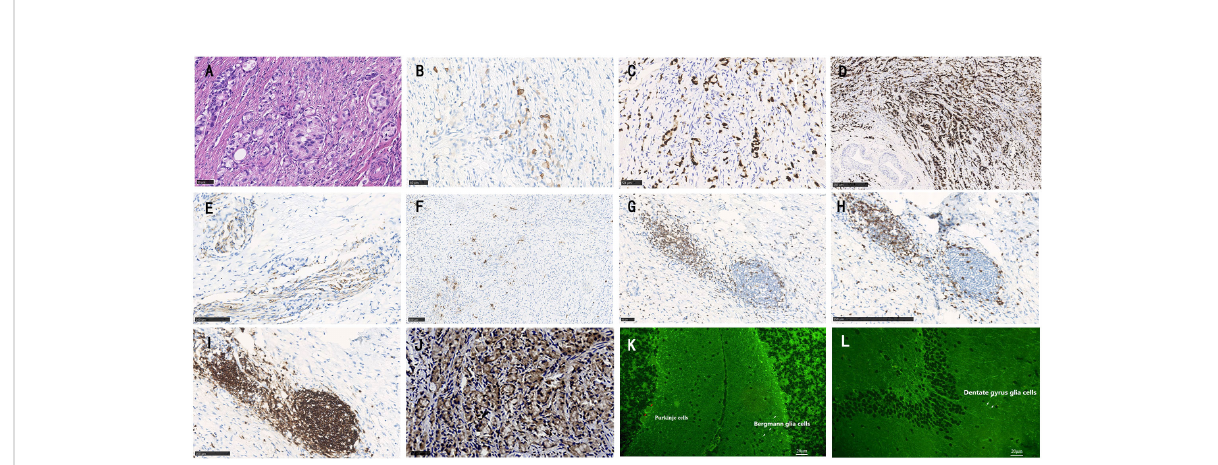
FIGURE 2 Histopathology of appendiceal goblet cell carcinoma of the patient. Tumor cells exhibit a goblet cell morphology and characteristically form small tight clusters (A) . The immunohistochemical staining shows moderate positivity for CK20 (B) , CDX-2 (C) , and strong positivity for carcinoembryonic antigen (CEA, D). Staining for synaptophysin (Syn, E), and chromogranin (F) is mild. Varying degrees of positivity are also shown in lymphocytes such as CD3+ T cells (G) , CD8+ T cells (H) and CD20+ B cells (I) . Immunohistochemistry shows positive staining for amphiphysin-IgG (J) . Tissue-based indirect immuno fl uorescence assay (TBA) of the patient ’ s serum detected fl uorescence responses, with speci fi c fl uorescence responses in Purkinje cells (red arrows) from the monkey cerebellum brain section (K) as well as dentate gyrus glial cells (white arrows) from the monkey hippocampal tissue. (A, – C, G, J) bar = 50 µm; D, H bar = 250 µm; (E, F, O) bar = 100 µm, (K, L) bar = 20